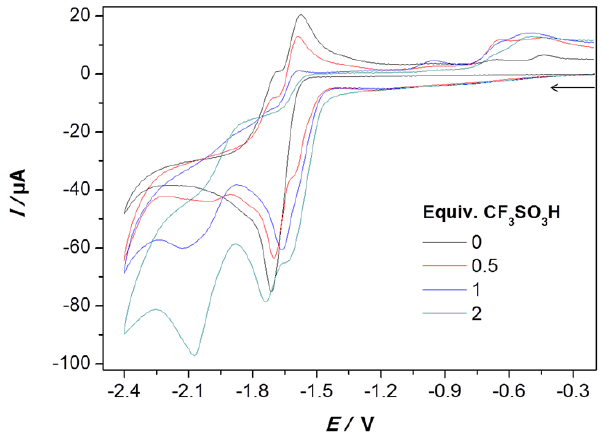
Figure 5. Cyclic voltammetry of complex 1.01 mM complex 1 (CH 2 Cl 2 /NBu 4 PF 6 ) in the presence of 0.5–2 equiv. CF 3 SO 3 H. Glassy carbon electrode (diameter = 3 mm). Potential, E , is in volt (V) against the ferrocenium/ferrocene couple. The arrows indicate the scan direction.